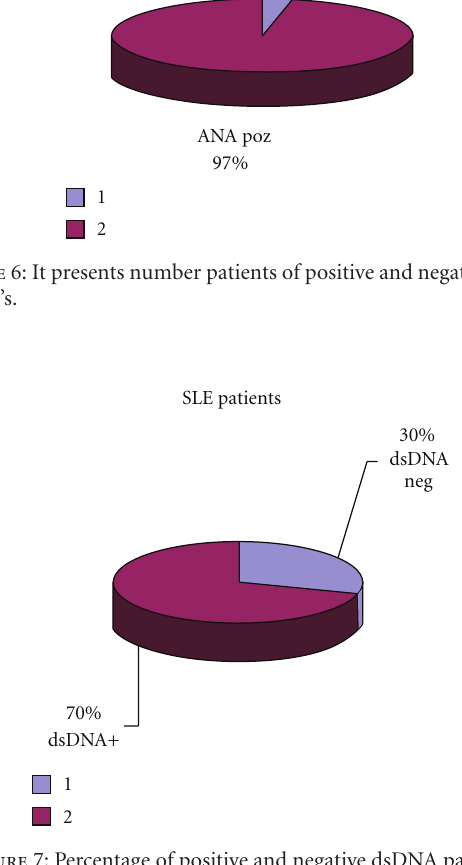
Figure 7: Percentage of positive and negative dsDNA